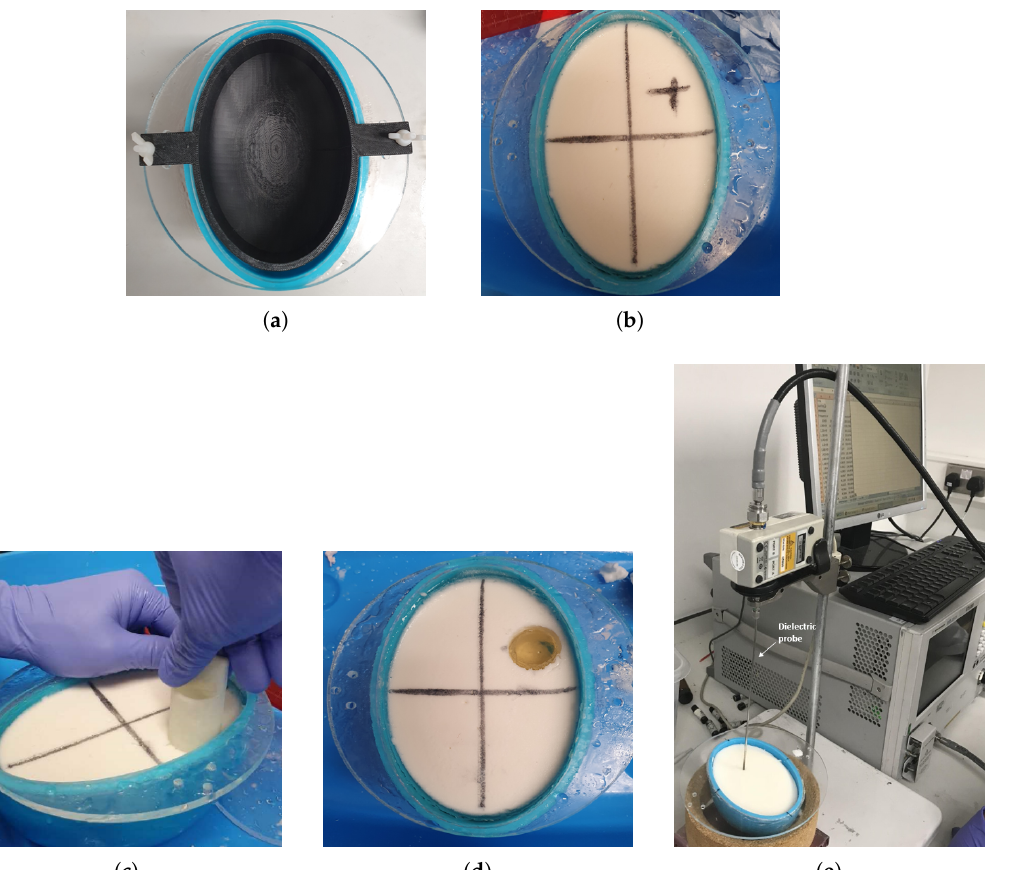
Figure 3. Summary of the head model construction: ( a ) Cylindrical 3-D printed mould to form the cerebrospinal fluid (CSF) and average brain layers; ( b ) The two-layer model after CSF and average brain phantoms are poured into the moulds (the CSF is a thin, transparent layer just inside the blue mould); ( c ) Creating a hole in the phantom to insert the stroke-like target; ( d ) Final two-layer phantom with a target of blood-mimicking phantom; ( e ) Setup with Keysight’s slim form probe to measure the dielectric properties of the